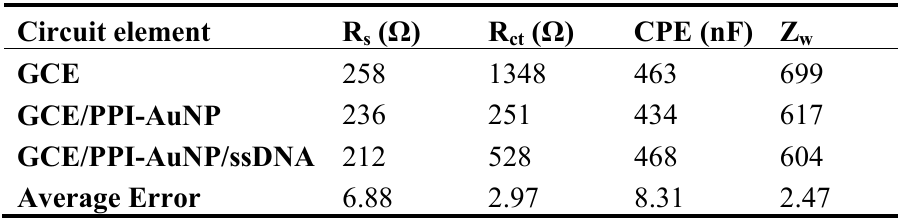
Table 2. The EIS parameters obtained from the circuit fitting of plots in Figure